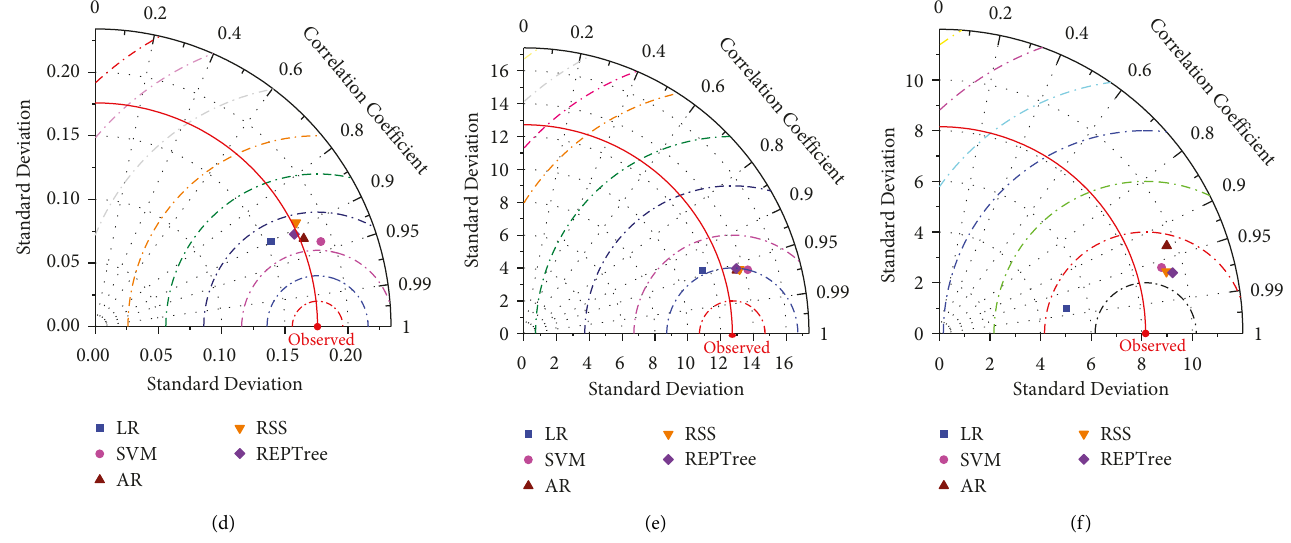
Figure 7: Comparison of model’s performances using the Taylor diagram for irrigation indices